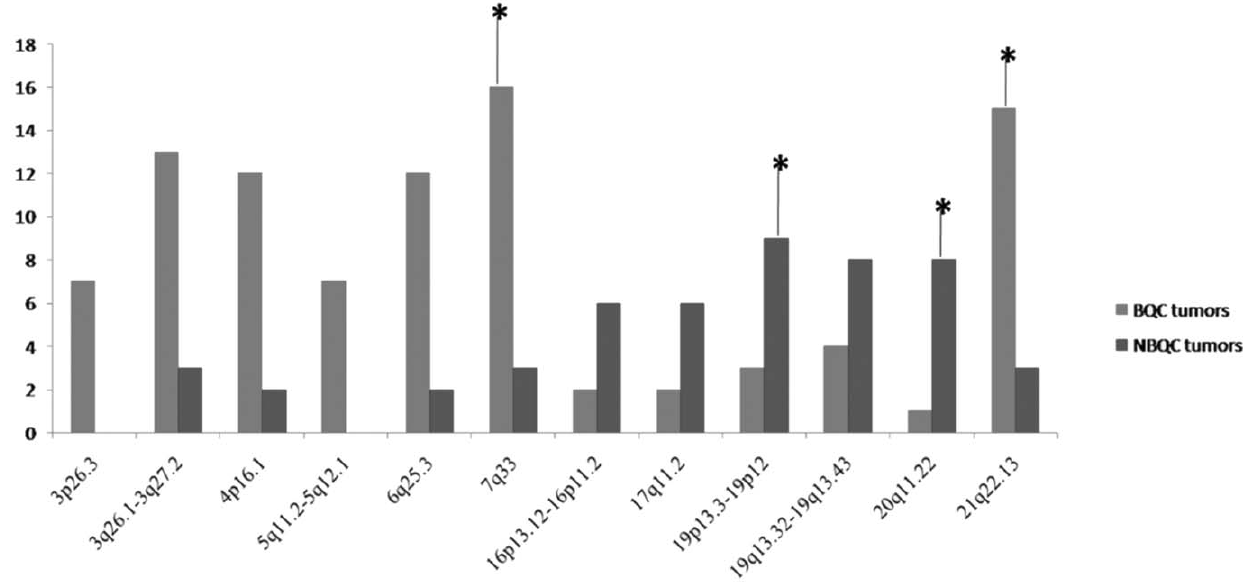
Figure 1. Chromosomal regions altered differently between BQC and NBQC breast tumors. *Regions significant after FDR correction. doi:10.1371/journal.pone.0043789.g001 PLOS ONE |